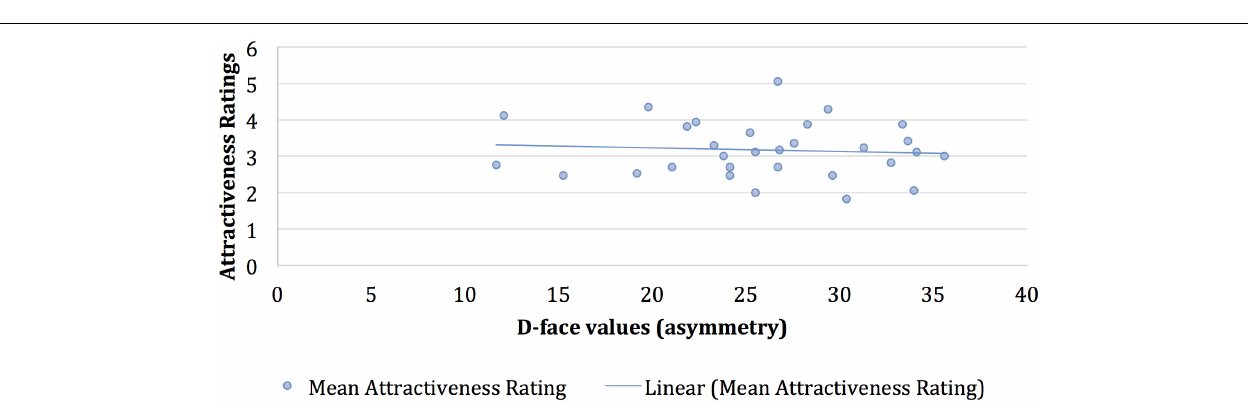
FIGURE 7 | Relationship between facial asymmetry values (D-face) and mean attractiveness ratings for the same 30 individuals in the face database with cosmetics